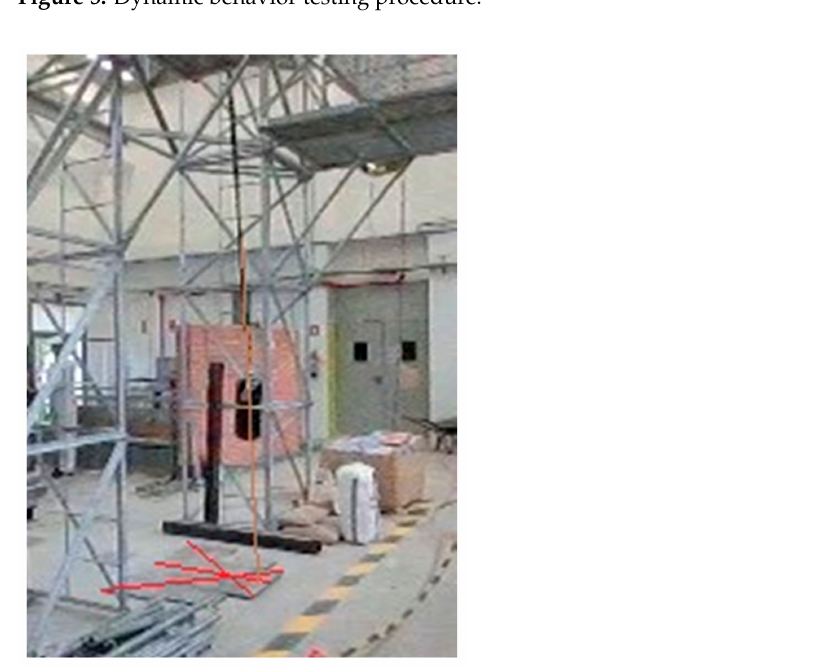
Figure 5. Dynamic behavior testing procedure.